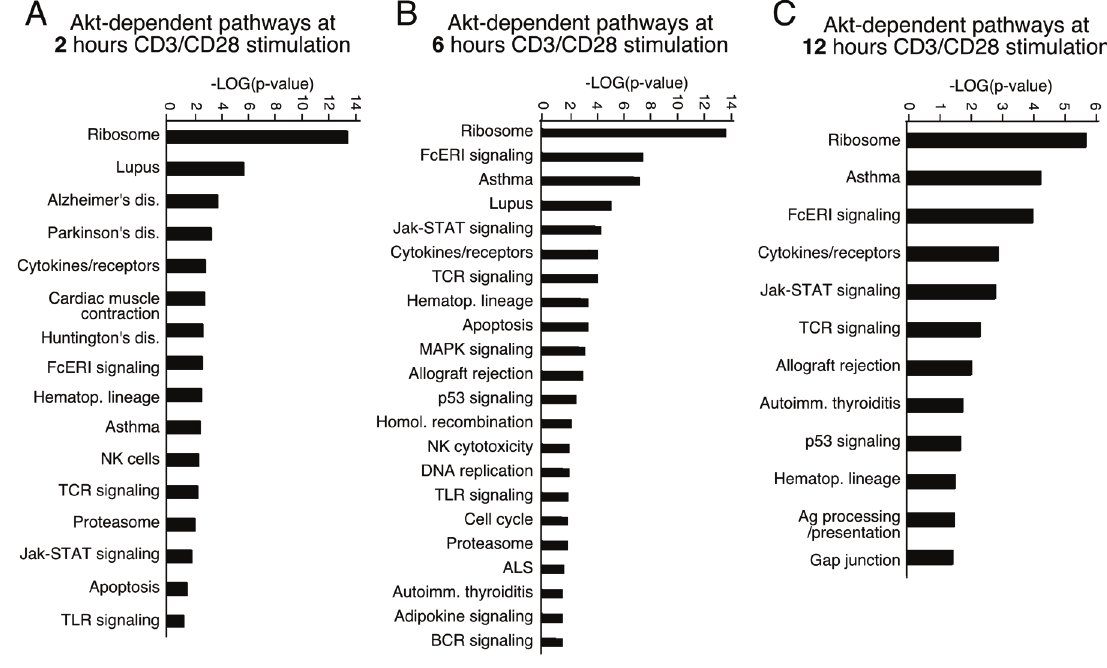
Figure 5. Functional classification of Akt dependent genes. Classification enrichment was determined using Pathway Express. Significance is indicated as –Log